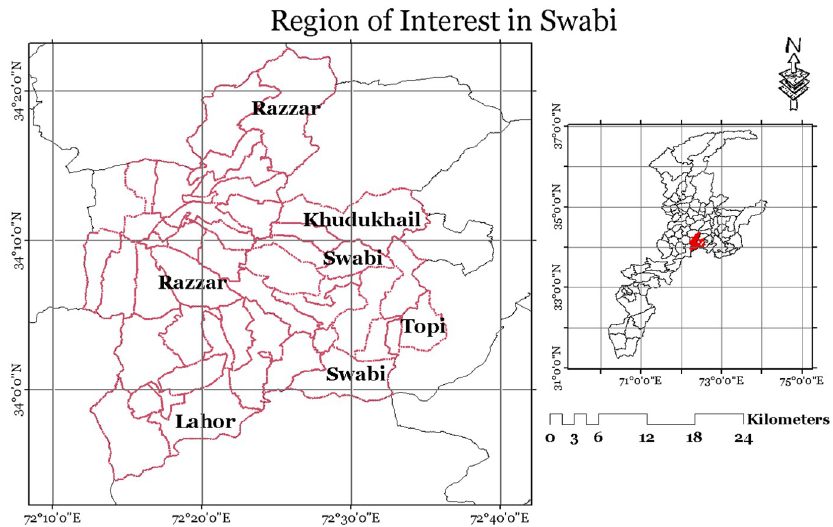
Fig 2. Locality map (generated using administrative boundaries and no copyright permission is required) of regions of interest. https://www.openstreetmap.org/map=5/30.671/69.360.